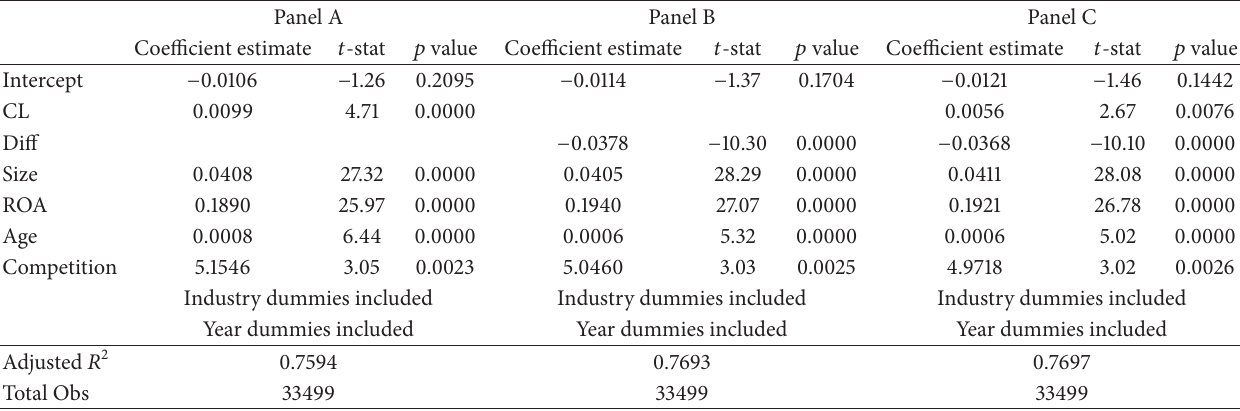
Table 3: Strategic positioning and production efficiency ( 𝑁 = 33,499). OLS regressions in the 2nd stage of 2-stage DEA analysis. Dependent variable: production efficiency.